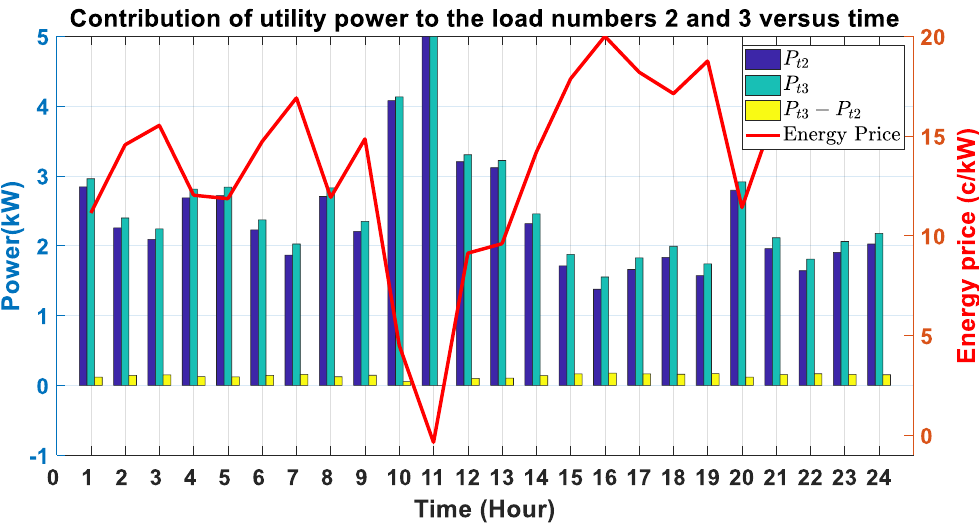
Figure 4. Contribution of utility power to load 2 and 3.